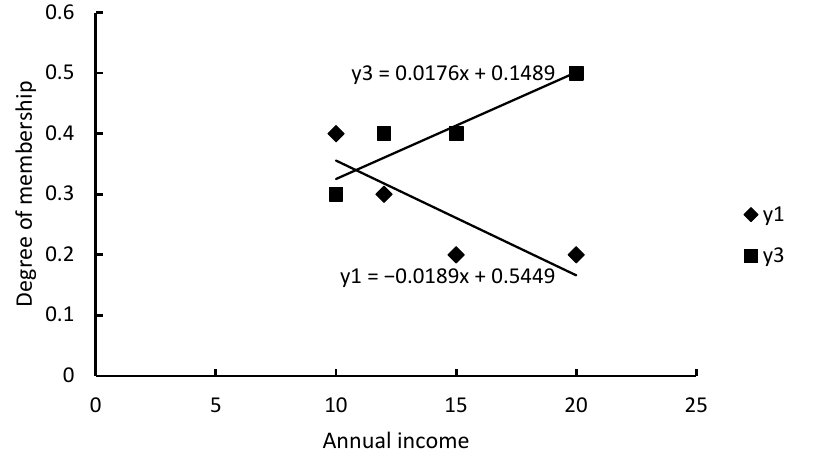
Figure A9. Single factor evaluation for the index of annual income (5–10 (inclusive) ten thousand yuan).